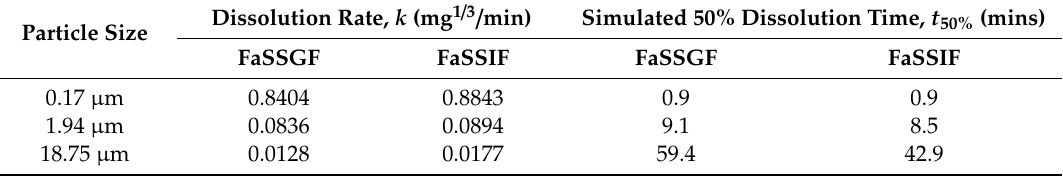
Table 4. Pharmacokinetic data of trans ‐ resveratrol after oral administration and intravenous administration.